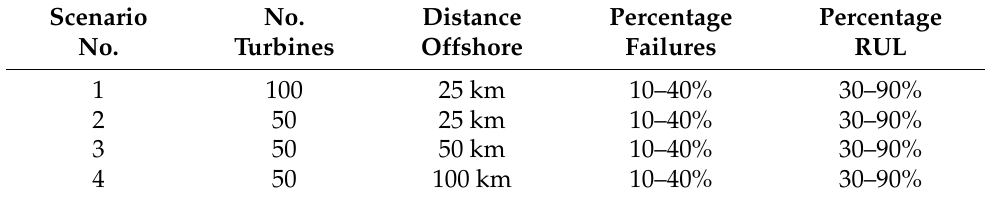
Table 4. Analysis